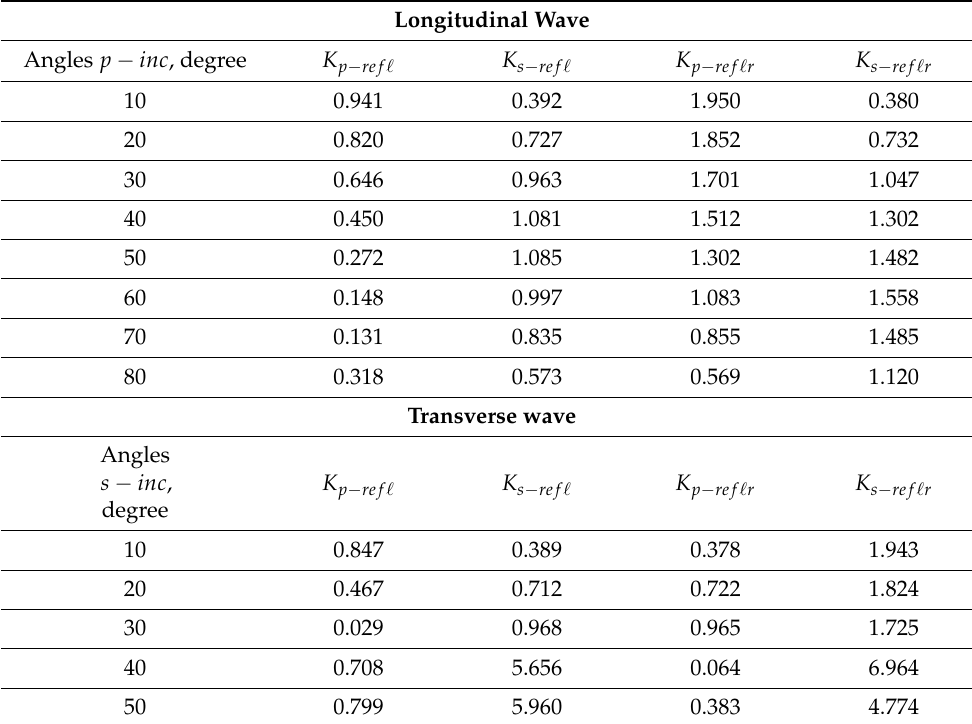
Table 3. Coefficients of reflection and refraction of the wave process in a contact pair of rails with pads. Longitudinal